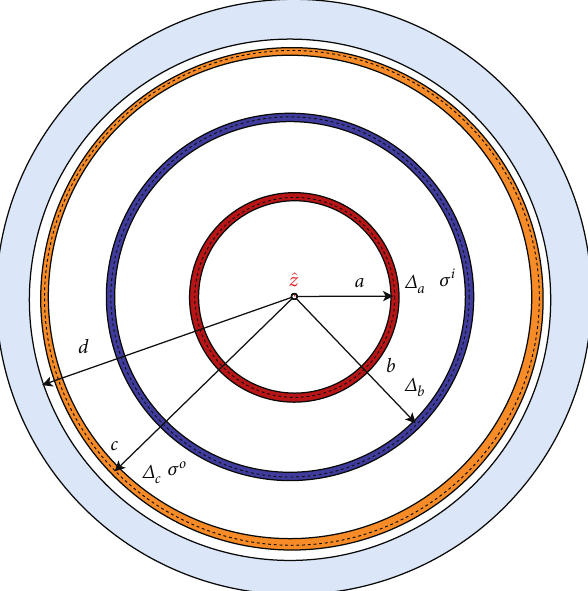
Figure 7: Simpli fi ed cross-section (not to scale) of an ideal superconducting magnet with an iron yoke with inner radius d .